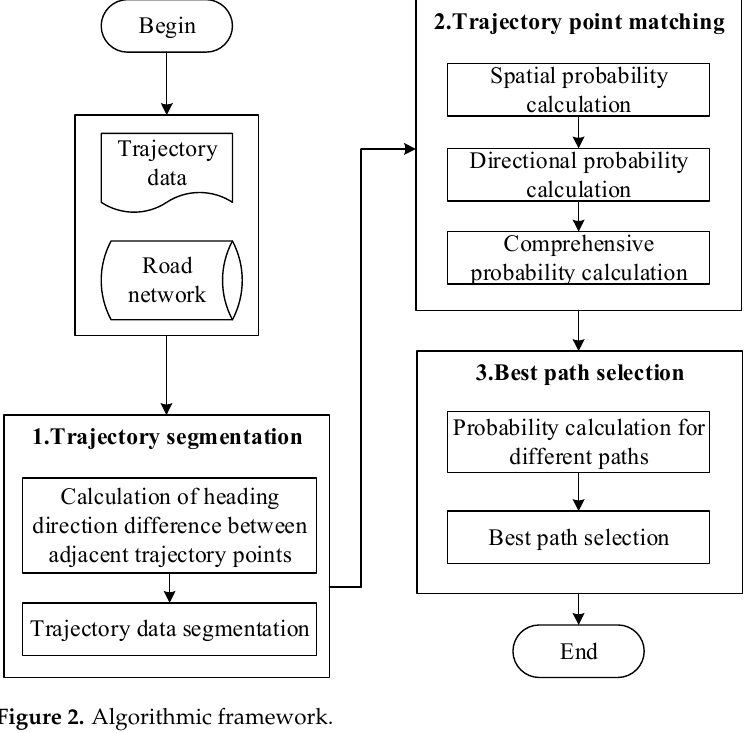
Figure 2. Algorithmic framework.